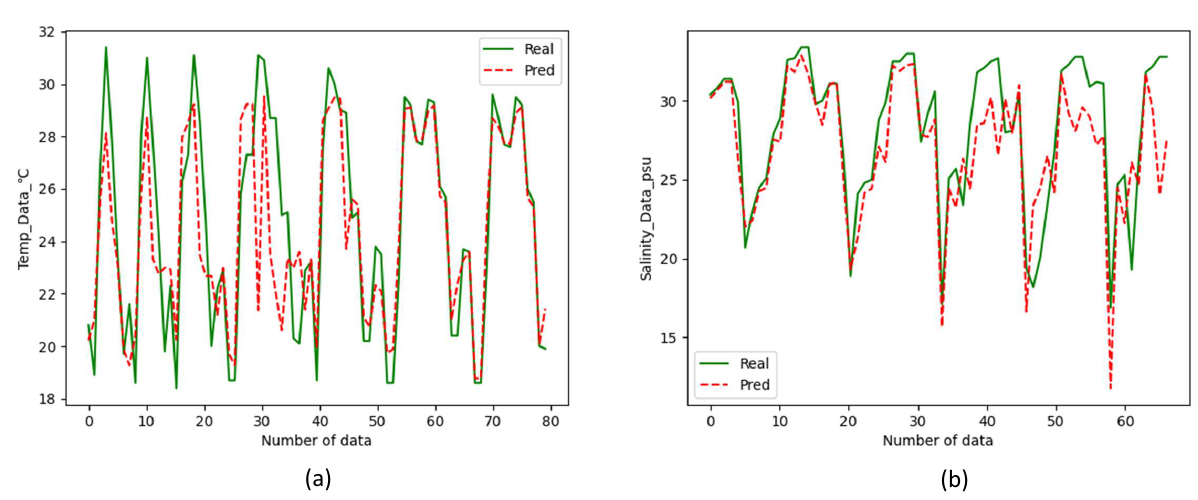
Figure 8. Performance of random forests in predicting nearshore water quality: ( a ) temperature and ( b ) salinity.